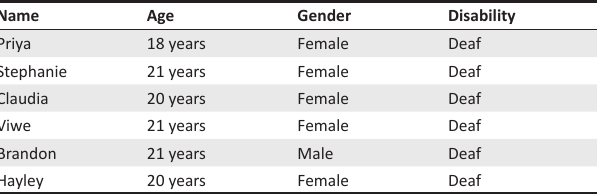
TABLE 1: Participant group 1: Tertiary training college for the deaf.